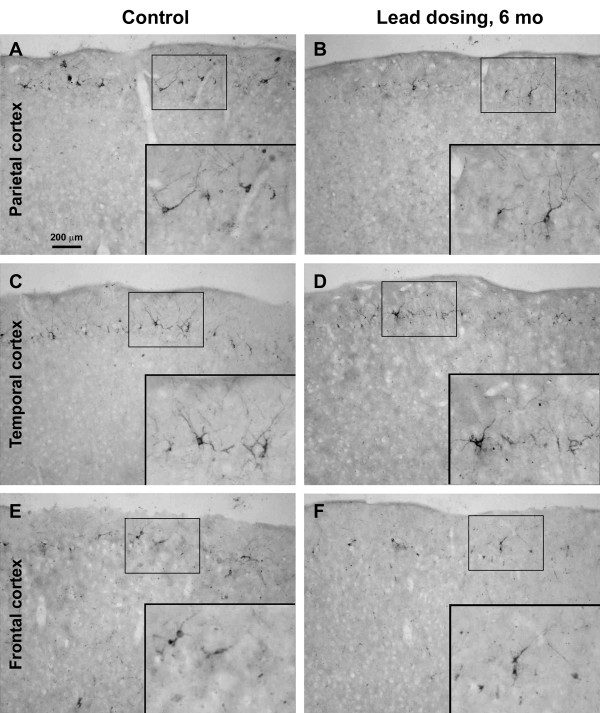
Doublecortin-immunoreactive (DCX+) cells in different cortical areas from Pb exposure (right panels) and age-matched control (left panels) groups surviving 6 months. A dramatic loss of DCX + cells occur in the Pb-treated relative to control animals over that parietal (A, B), temporal (C, D) and frontal (E, F) cortex. Scale bar in panel A = 200 μm applying to main panels, equivalent to 100 μm for enlarged inserts.